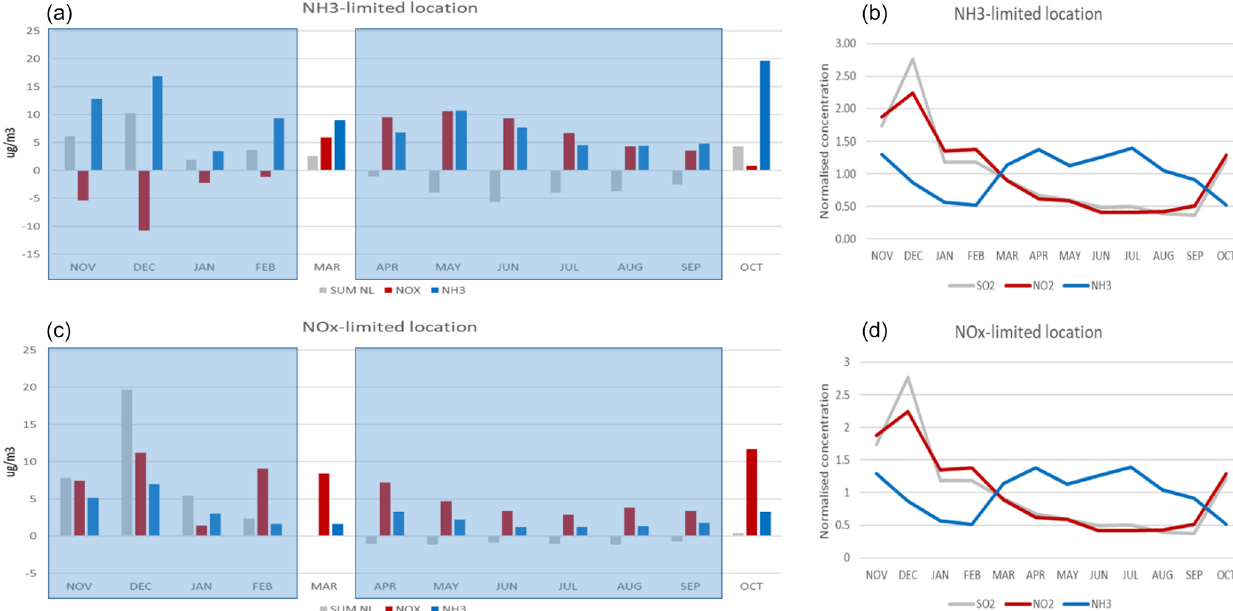
Figure A1. Monthly averaged responses to NH 3 (blue), NO x (red) reductions (25%) and interaction terms (grey) at two locations: Bergamo (a, b) and Mantua (c, d) . Panels (b) and (d) shows the monthly evolution of the concentrations of NO 2 , NH 3 and SO 2 at those two locations. Note that concentrations are normalised by their average